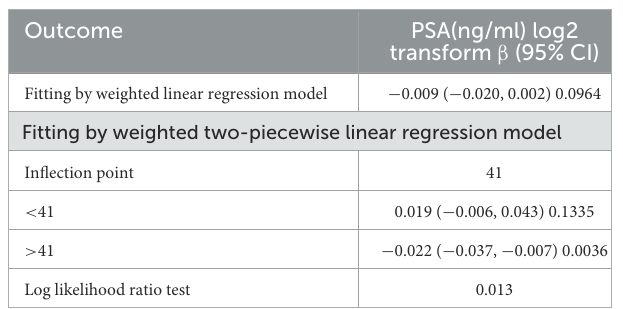
TABLE 3 Non-linearity addressing by weighted two-piecewise linear